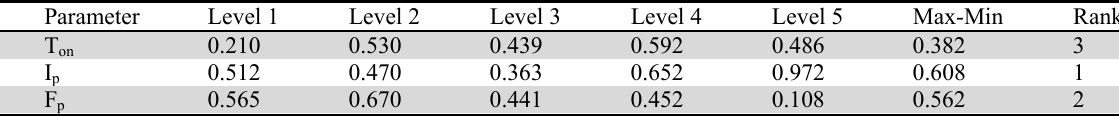
Main effects factor on VIKOR